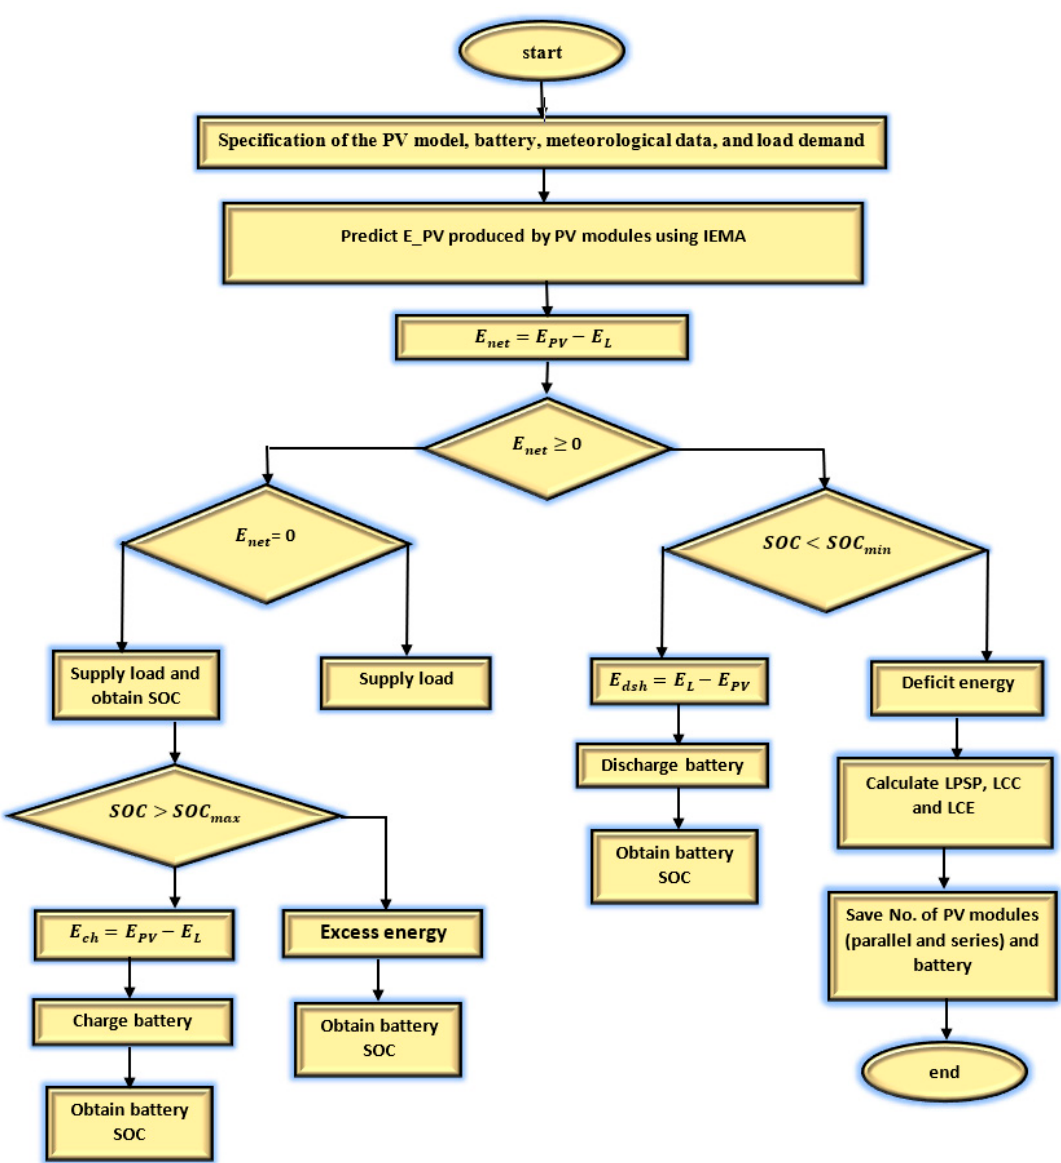
Figure 5. The flow chart of energy management of a SAPV system.